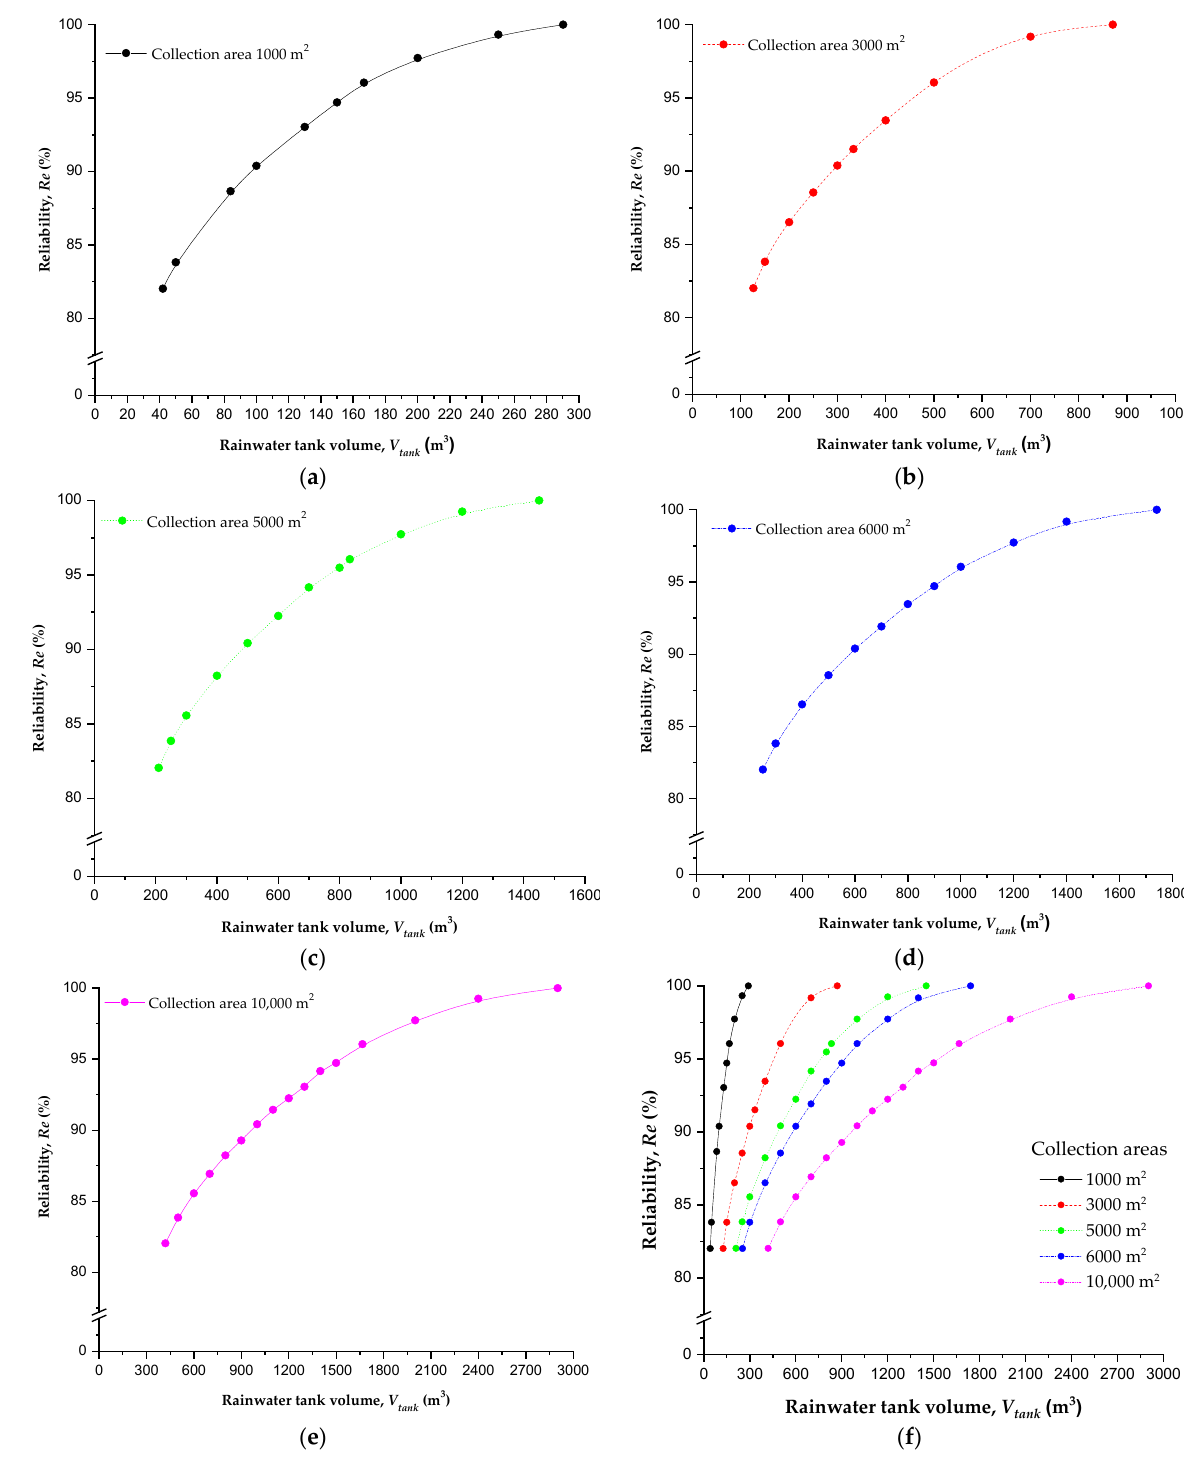
Figure 6. Reliability curves of covered rainwater harvesting system in relation to tank sizes to meet the demand of a tomato crop cultivated in greenhouses with rainwater collection areas: ( a ) 1000 m 2 ; ( b ) 3000 m 2 ; ( c ) 5000 m 2 ; ( d ) 6000 m 2 ; and ( e ) 10,000 m 2 . A comparative presentation was also presented ( f ).